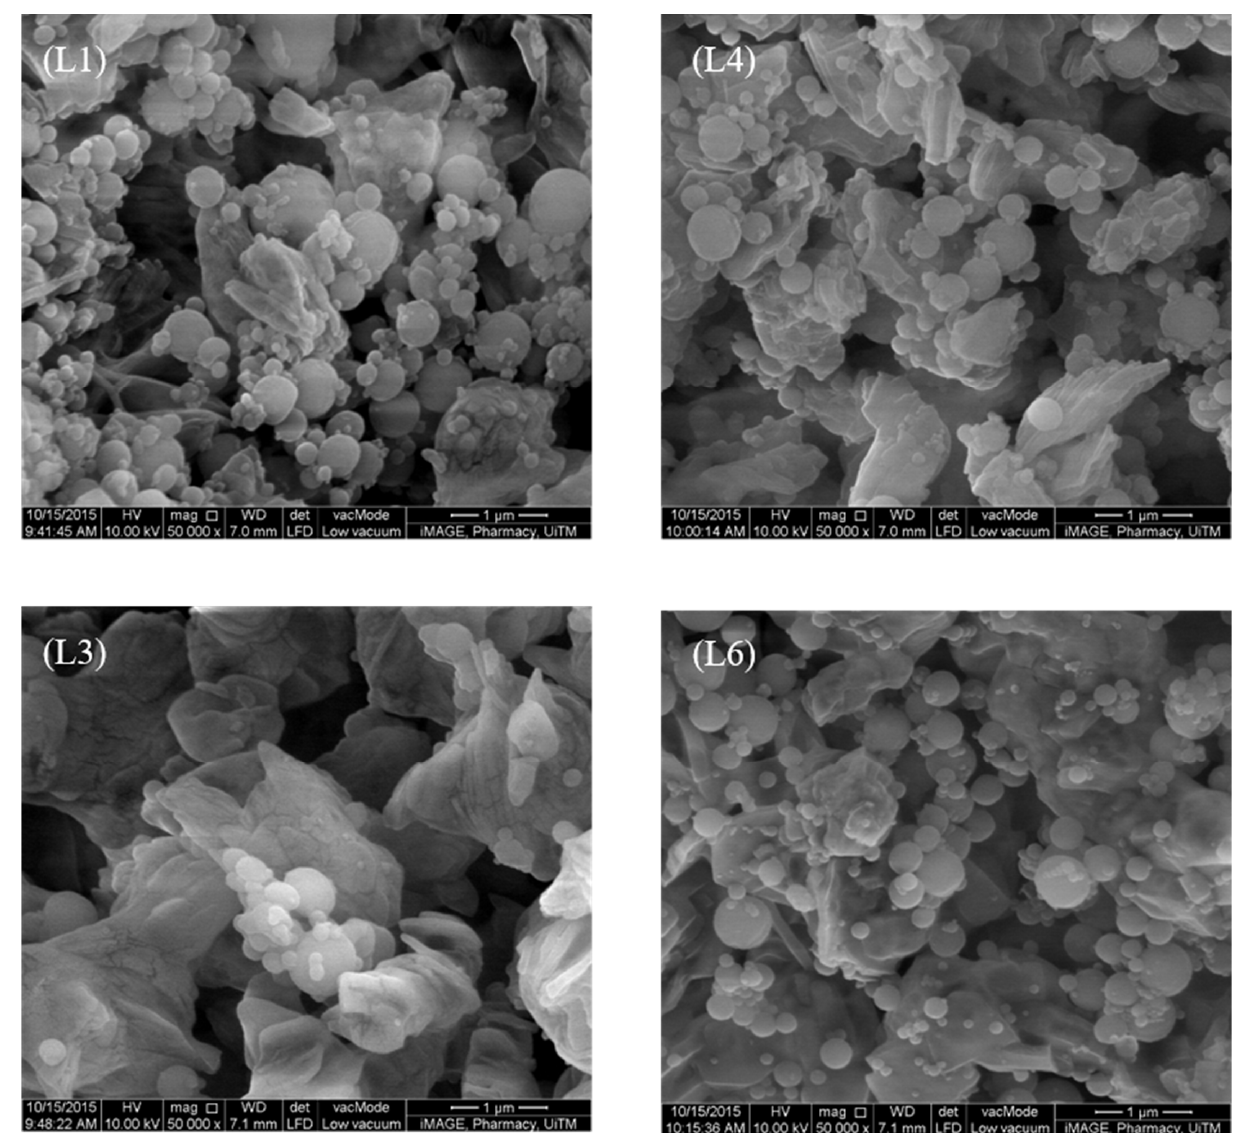
Figure 4. SEM micrographs of chitosan nanoparticle–lactose–PEG microparticle blends. Table 3. Aerosolization and inhalation profiles of chitosan nanoparticles admixed with lactose-PEG microparticles L1, L3, L4 and L6.